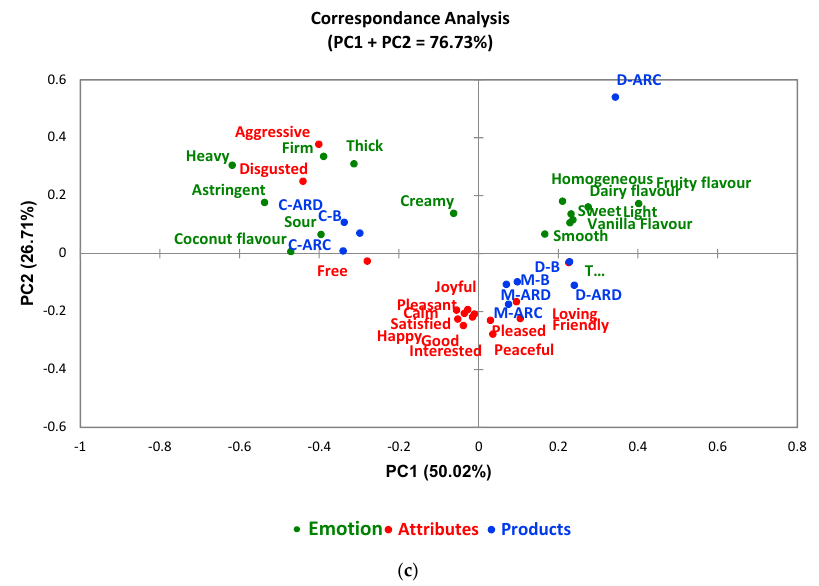
Figure 4. ( a ) Correspondence analysis of the emotional terms for the yogurts under the different environments, ( b ) principal coordinate analysis of the emotional terms with the overall liking score, and ( c ) correspondence analysis of the merged results from the attributes and emotions of the yogurt samples. The description of the treatment’s labels can be found in the footnote of Table 2.